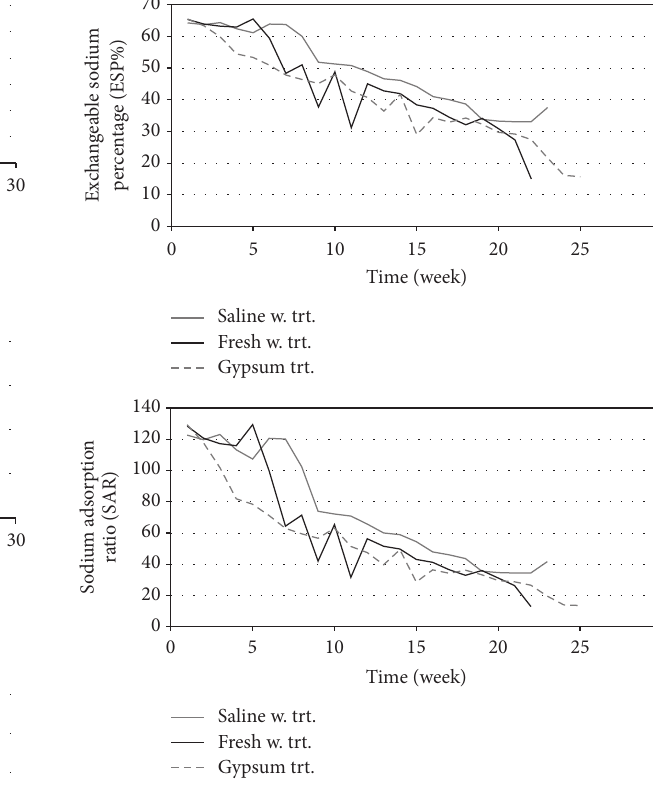
Figure 5: SAR and ESP in drainage water during the leaching experiment for gypsum, fresh water, and saline water